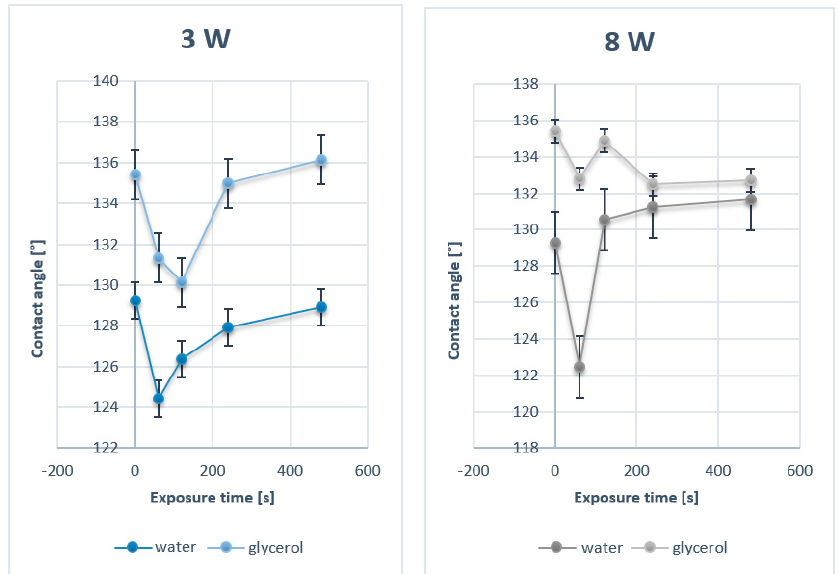
Figure 2. Contact angles of pristine PFA and PFA modified by plasma at 3 and 8 W for 60, 120, 240, and 480 s.